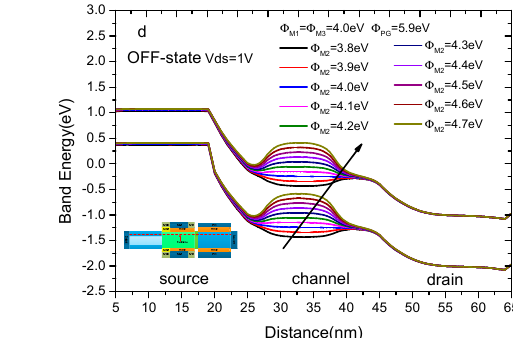
Figure 8. ( a ) Simulated log scale and linear scale transfer characteristics of DMMG-HJLTFET with different control gate work function ( Φ M2 ); ( b ) the distribution of electric field at the surface with different control gate work function ( Φ M2 ); ( c ) the variation of ON-state energy band with different control gate work function ( Φ M2 ); ( d ) the variation of OFF-state energy band with different control gate work function( Φ M2 ).